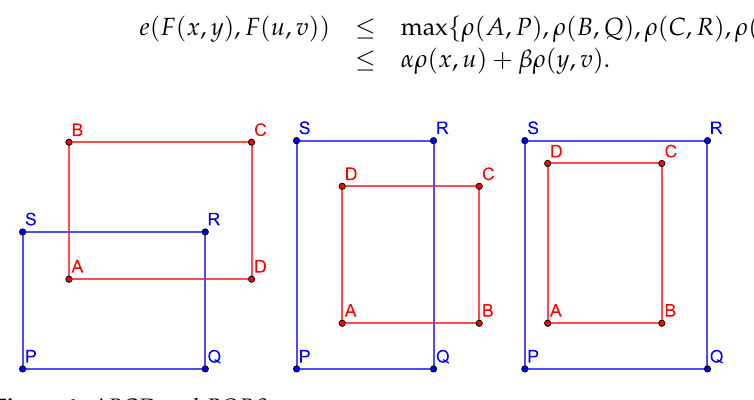
Figure 4. ABCD and PQRS